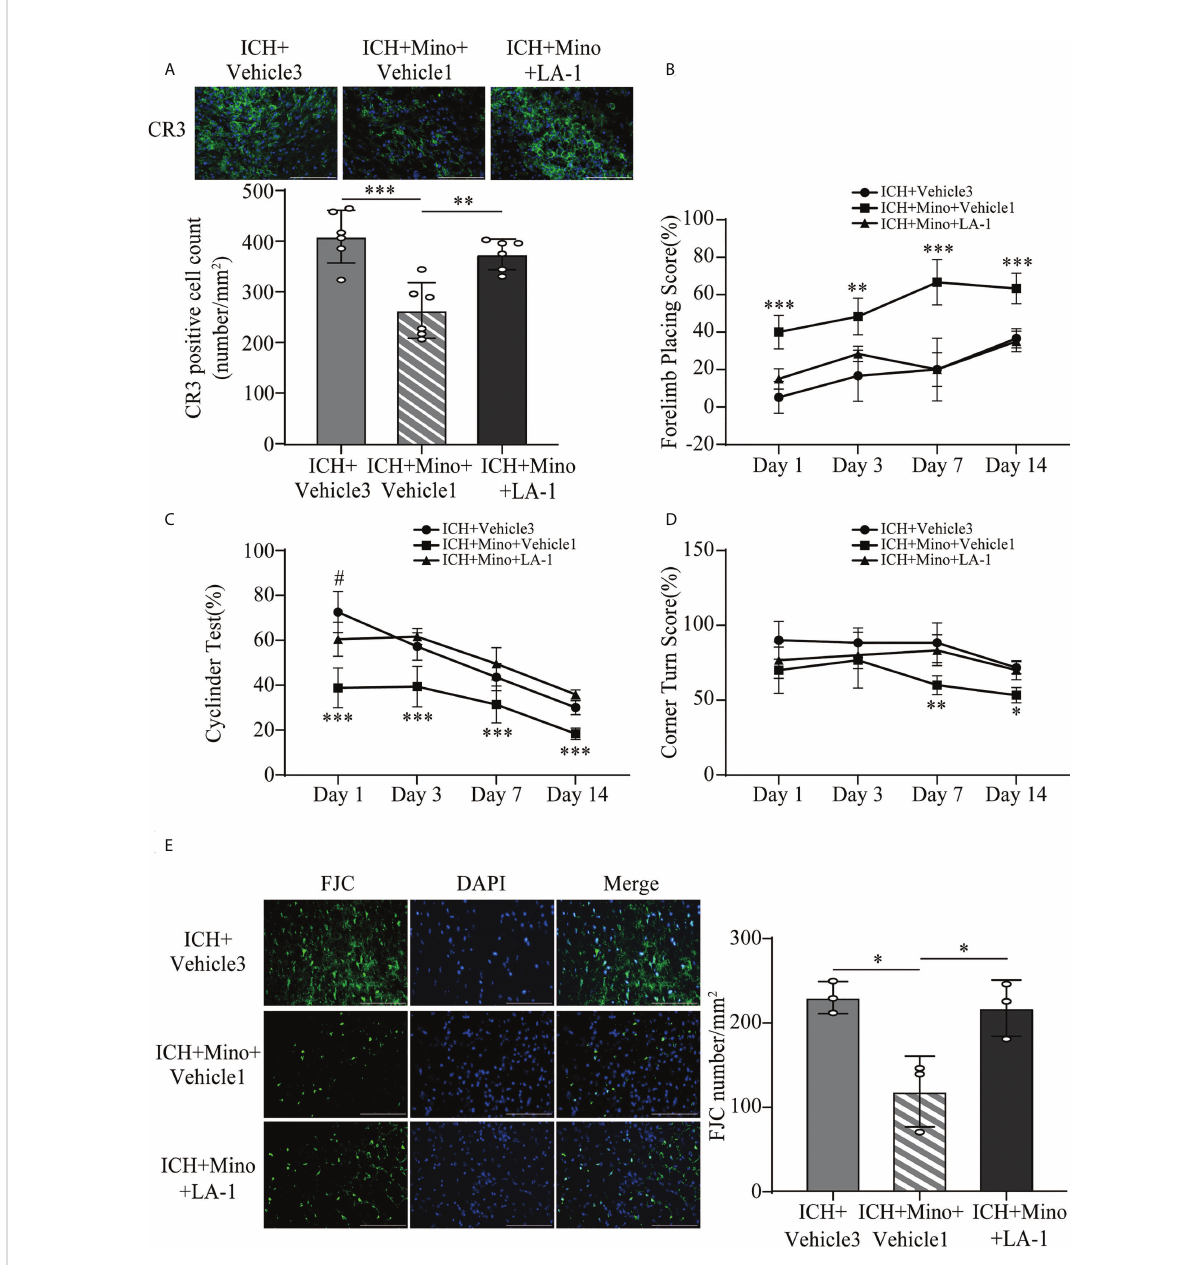
FIGURE 9 CR3 activation reverses minocycline-mediated neuroprotection against ICH. (A) Representative immuno fl uorescence images and quantitative analysis of CR3 positive cells. n = 6. **P <0.01, ***P <0.001 by one-way ANOVA. (B – D) Quanti fi cation of neurological function in the forelimb placing test (B) , cylinder test (C) , and corner turn test (D) at days 1, 3, 7, and 14. N = 6. **P <0.01 versus ICH + Mino + LA-1 group, ***P <0.001, # P <0.05 versus ICH + Mino + LA-1 group by two-way ANOVA. (E) Representative immuno fl uorescence images and quantitative analysis of FJC-positive cells in the ipsilateral cerebral cortex. n = 3. *P <0.05 by one-way ANOVA. Scale bar = 100 m m. Data are represented as mean ±